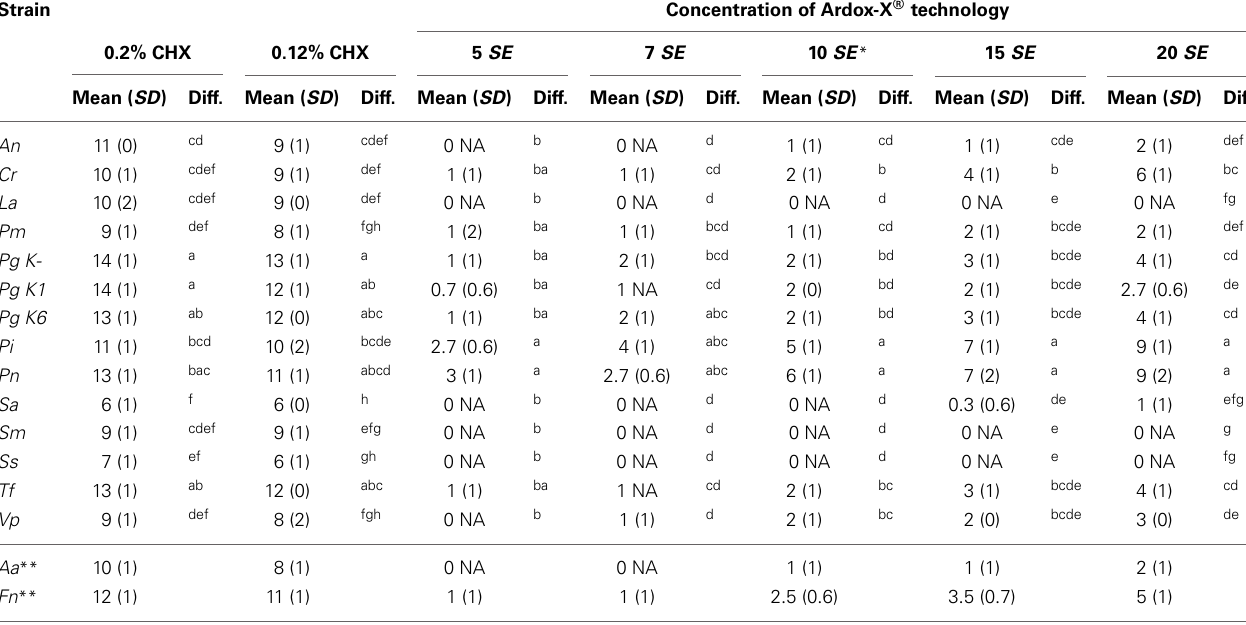
Table 2 | Results of the Agar Diffusion assay, performed in triplicate. Strain Concentration of Ardox-X ® technology 0.2%